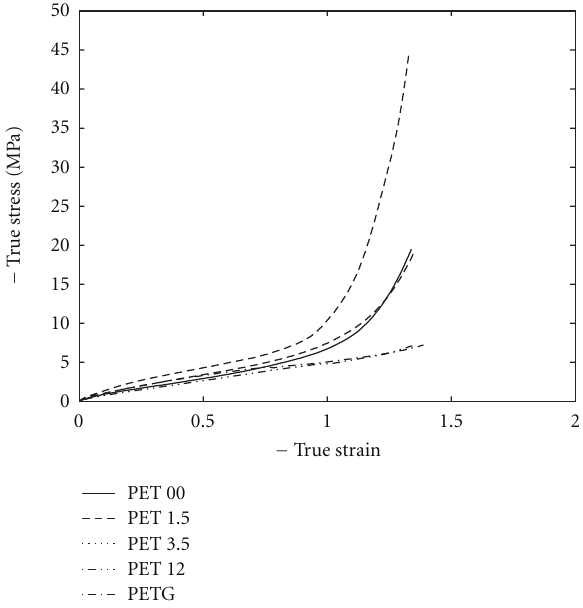
Figure 6: Material comparison, plane strain compression at 100 ◦ C and 0.1/s.